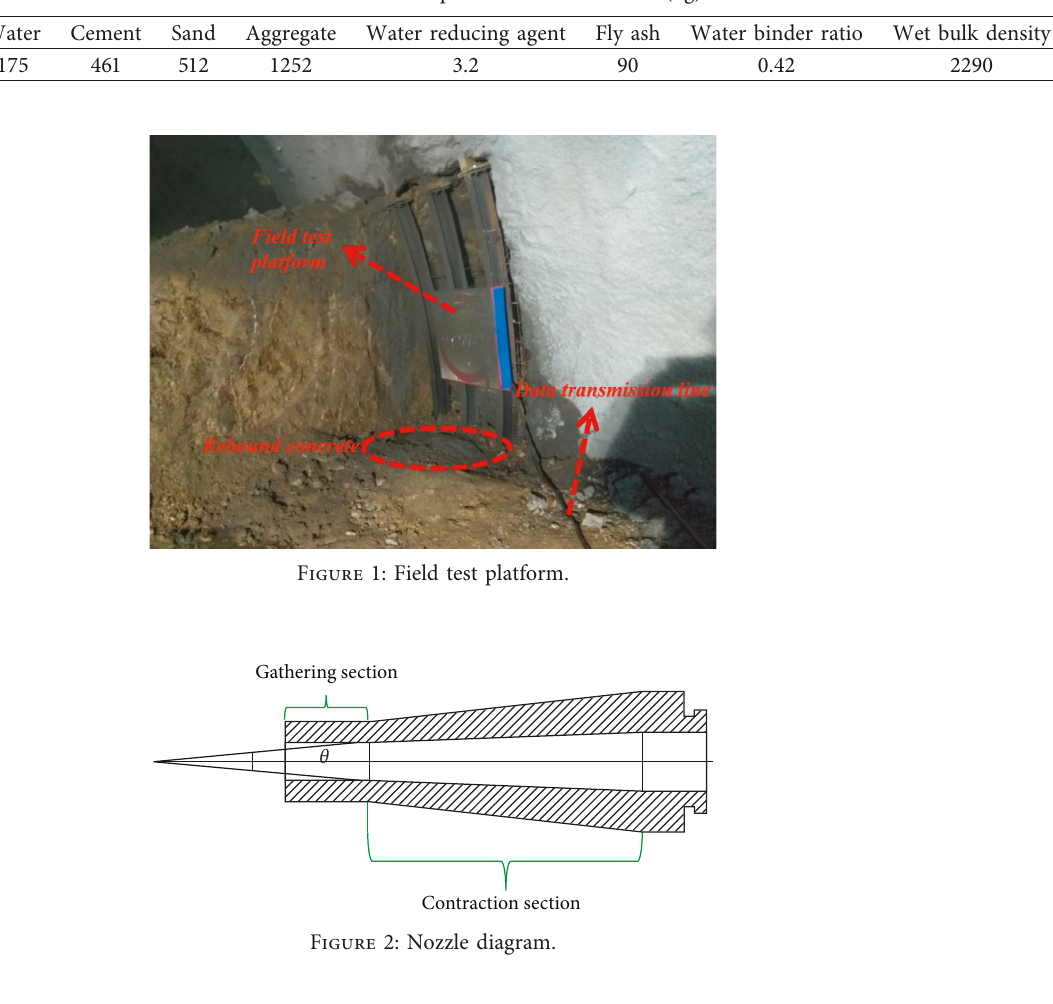
Table 1: Content of each component of C30 concrete (kg).